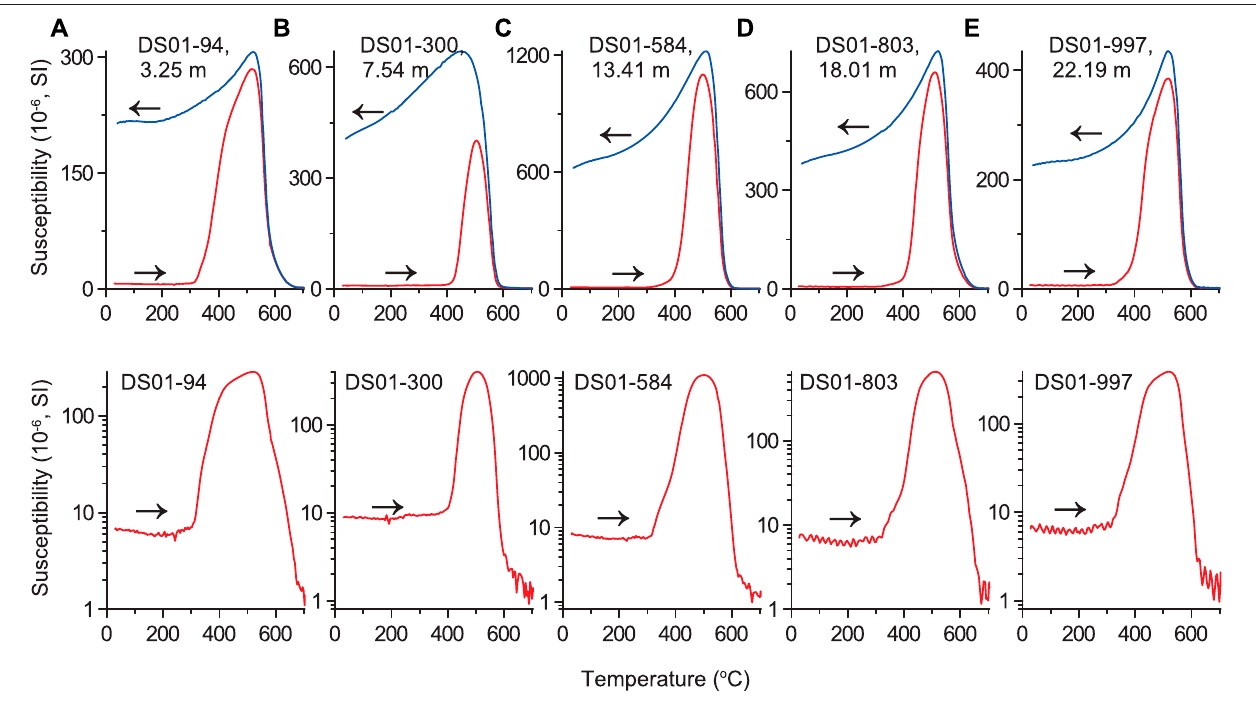
FIGURE 2 | Temperature-dependent magnetic susceptibility ( κ lf -T) curves for representative samples from core DS01. Arrows indicate heating (red) and cooling (blue) runs.